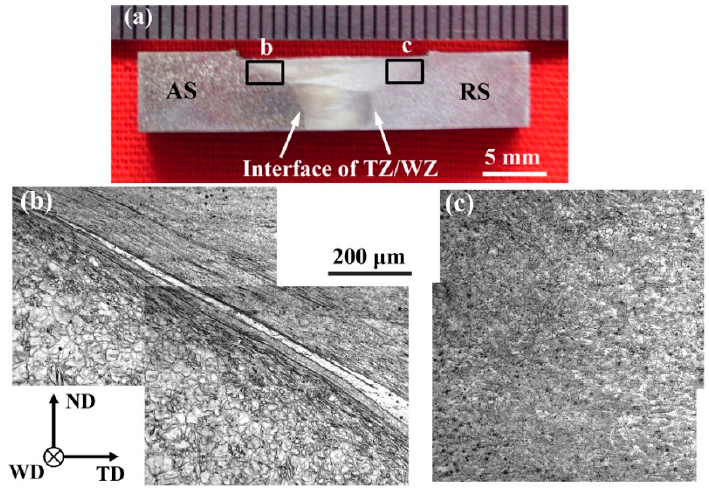
Figure 2. Interfaces between the TZ and WZ of FSW Mg alloys: ( a ) macro photo; ( b ) the interface in AS; and ( c ) the interface in RS